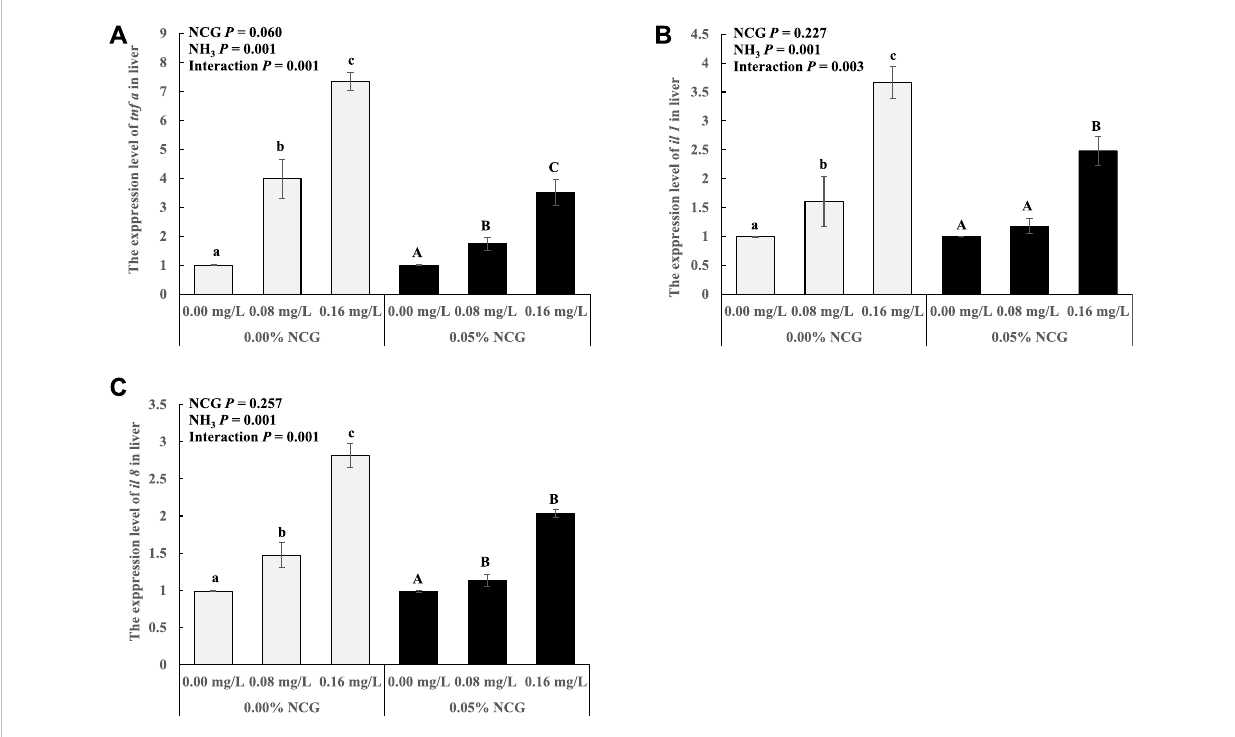
FIGURE 2 Relativeexpressionlevelsofantioxidant-relatedgenes tnf ɑ (A) , il1 (B) ,and il8 (C) inliver.TherelativeexpressionofthetranscriptfromqRT-PCRwas calculated based on the standard curve and normalized to the β -actin and gapdh mRNA level ( n = 3). The different letters represent existing signi fi cant differences between the three ammonia levels ( p <